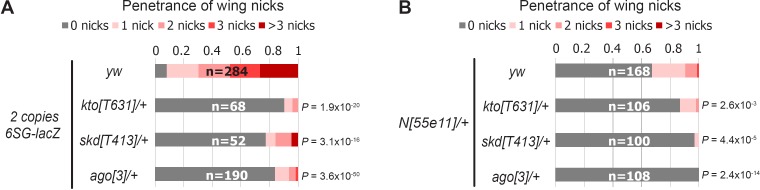
Decreased gene dose of the Cdk8-Mediator submodule suppresses the formation of wing nicks.(A) Wing notching penetrance and severity from flies containing 2 copies of 6SG-lacZ in wild-type (yw) or heterozygotes of components of the Cdk8-Mediator submodule or Drosophila Fbw7 (ago). Wild-type data is the same as Figure 3A as it was performed in the same experiment. (B) Wing notching penetrance and severity from N heterozygotes crossed to a wild-type (yw) or heterozygotes of either components of the Cdk8-Mediator submodule or ago. Wild-type data is the same as Figure 3B as it was performed in the same experiment. Number of wings scored (n) for each genotype is noted. Proportional odds model with Bonferroni adjustment.